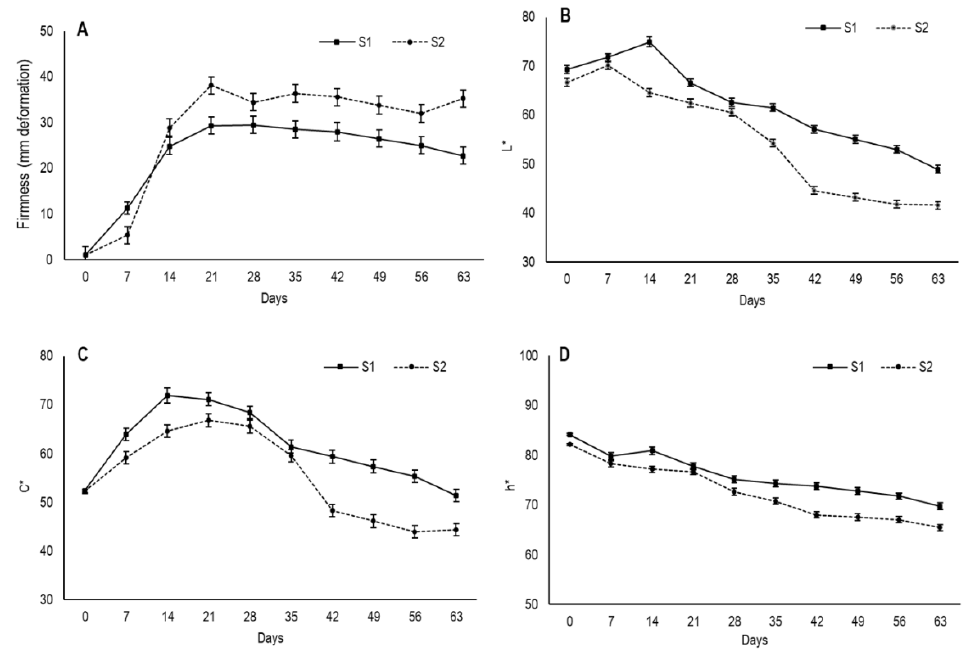
Figure 4. Changes in the ( A ) firmness, ( B ) lightness- L* , ( C ) chroma- C* and ( D ) hue angle- h* values during the drying process of persimmon cv. Rojo Brillante in two maturity stages (S1 and S2). Vertical bars represent Least Significant Differences (LSD) intervals ( p ≤